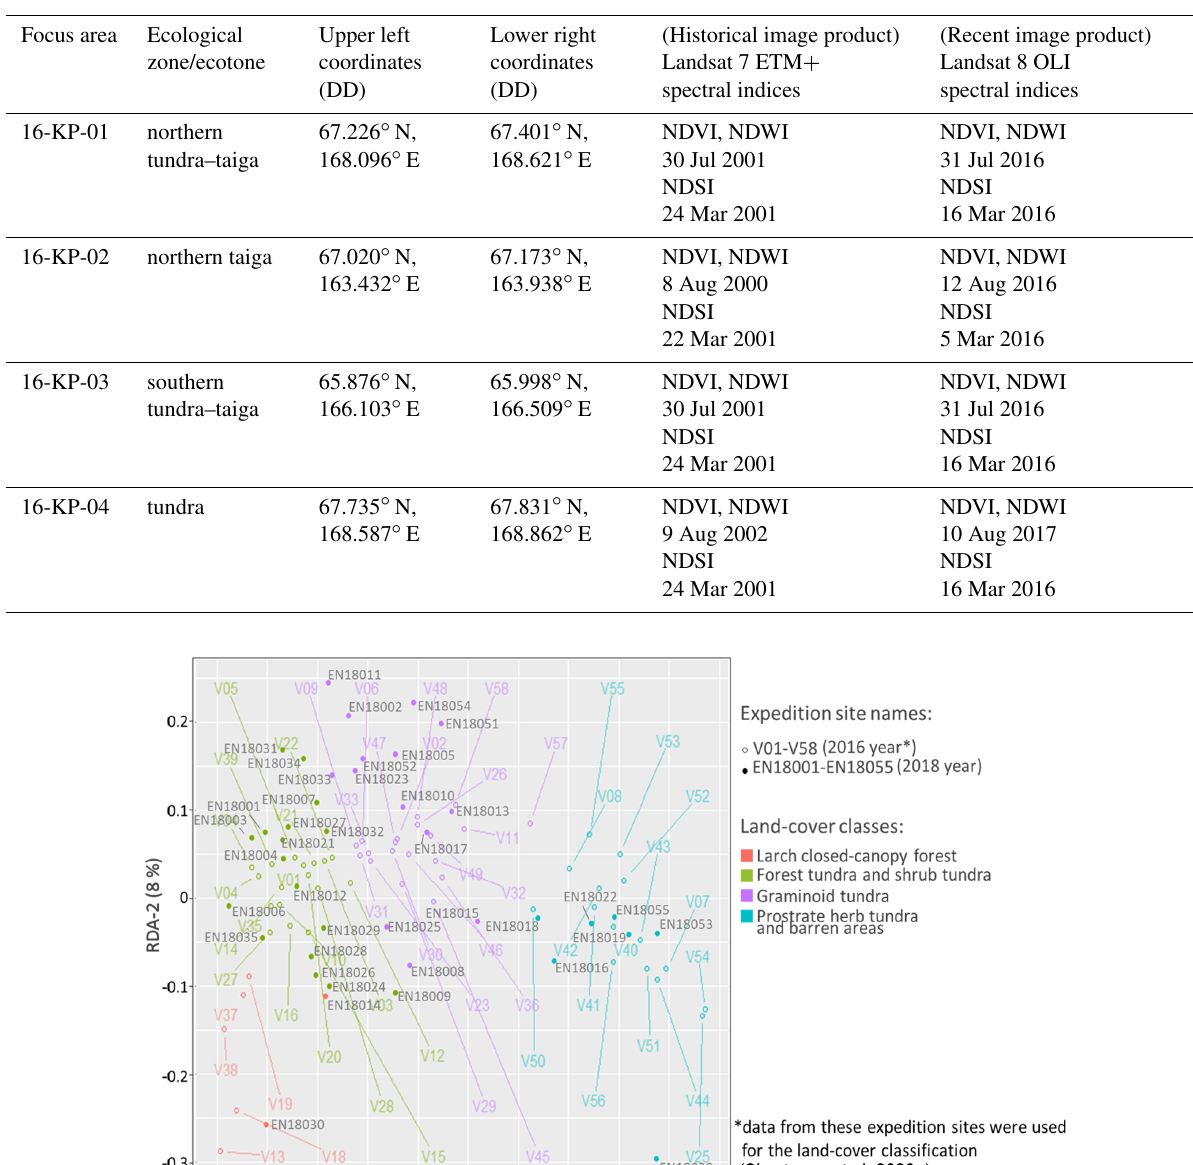
Table 1. The four focus areas with corner coordinates (decimal degrees (DD), WGS 84) and acquisition times of the historical and recent Landsat spectral indices (NDVI and NDWI for peak summer, NDSI for snow-covered conditions) used for the redundancy analysis (RDA).